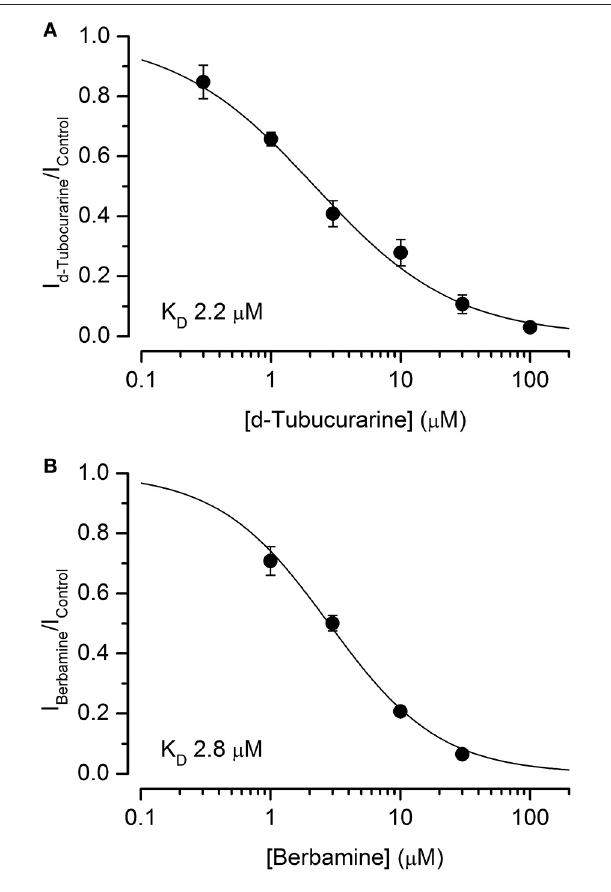
FIGURE 7 | d-Tubocurarine and berbamine block MET channels with similar half-blocking concentrations. (A,B) Dose-response curves of MET channel block by dTC (A) and berbamine (B) derived from currents recorded at − 104 mV and fit with Equation (2). dTC: K D 2.2 µ M, Hill coefficient 0.80; berbamine: K D 2.8 µ M, Hill coefficient 1.02. From 5 to 14 cells were used for each data set.